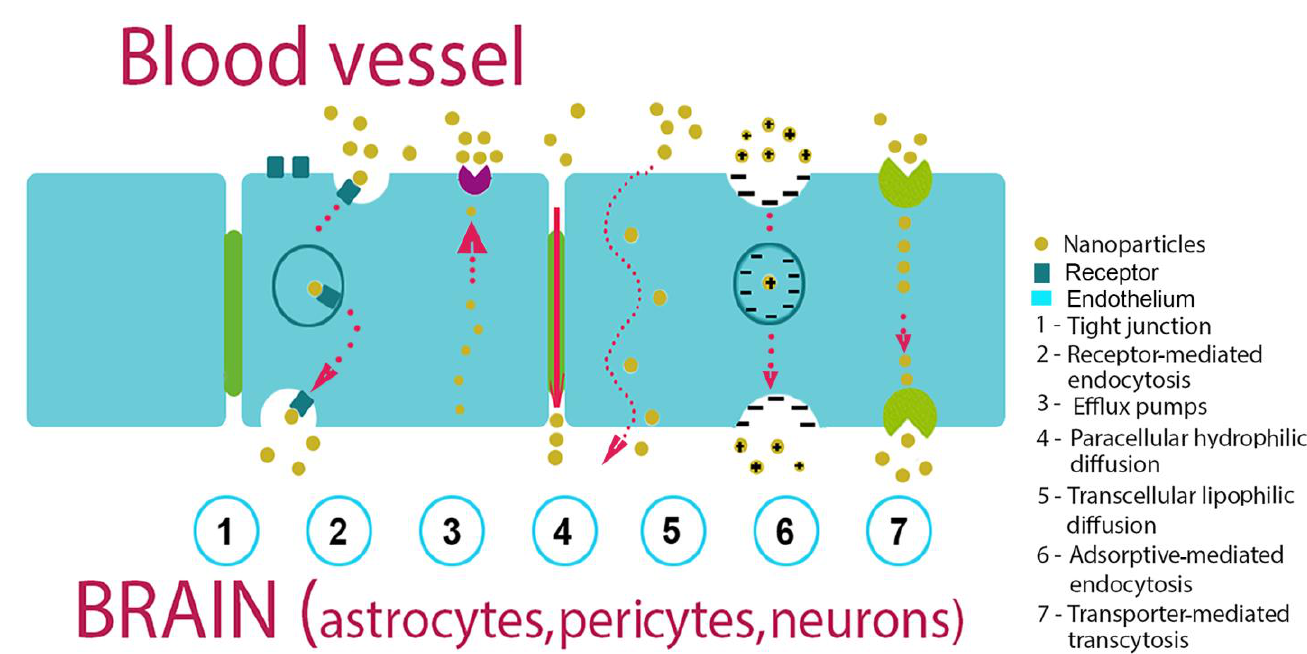
Figure 2. Mechanisms of NPs penetration via the histohematic barriers (blood–brain barrier (BBB) used as an example).